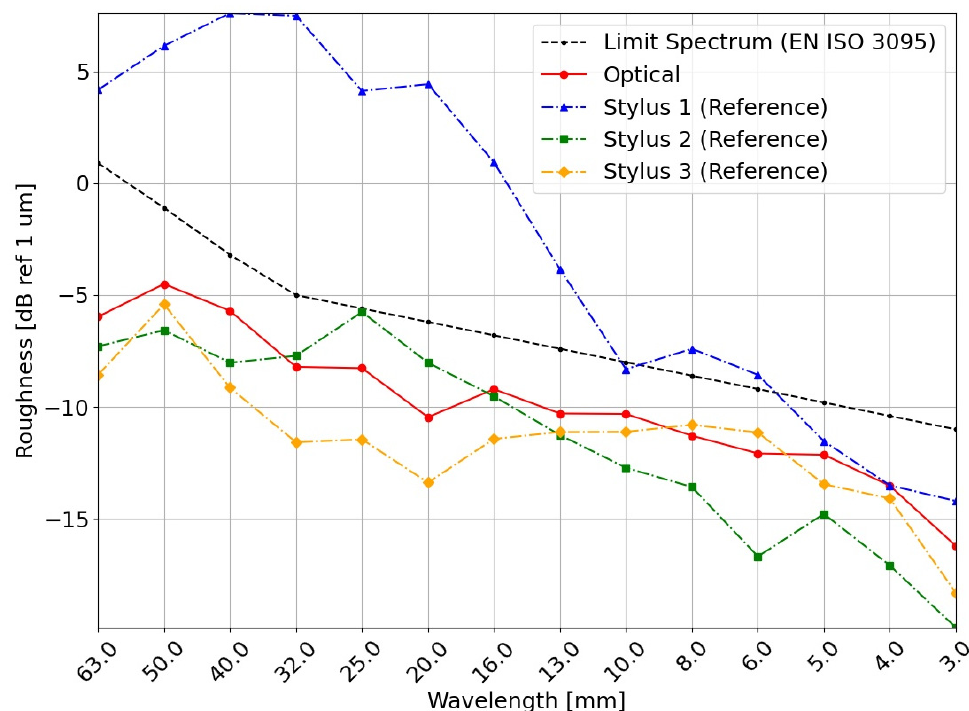
Figure 7. Spectrum of acoustic roughness for measurement of the optical system at 50 km h − 1 , compared with reference section B and the limit spectrum from EN ISO 3095 [22].